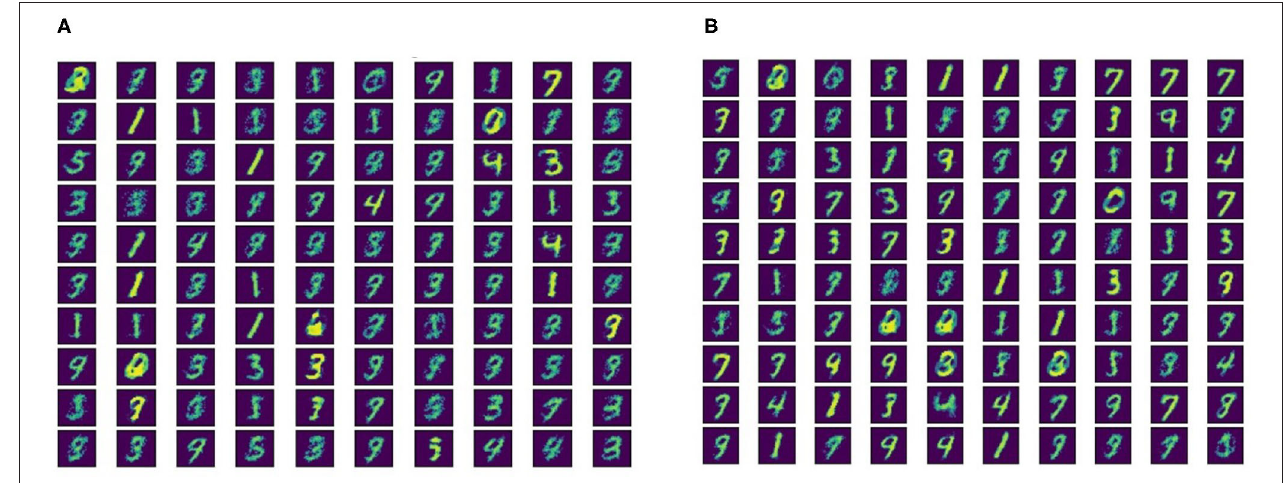
FIGURE 5 | Neuron connection weights for learned digit representations for (A) SFR = 0.9 and (B) SFR = 2.1.